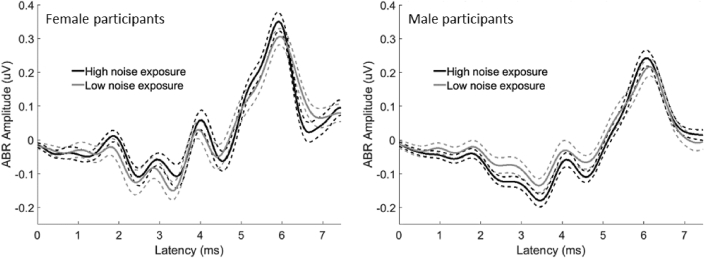
Group-level grand averaged ABR waveforms. Black lines denote the high noise exposure group (n = 32, nine female) and grey lines denote the low noise exposure group (n = 30, 12 female). Solid lines represent the average and dashed lines represent the standard error. In both panels, the grand average was created by first averaging across left and right ears within subjects, and then averaging across subjects.